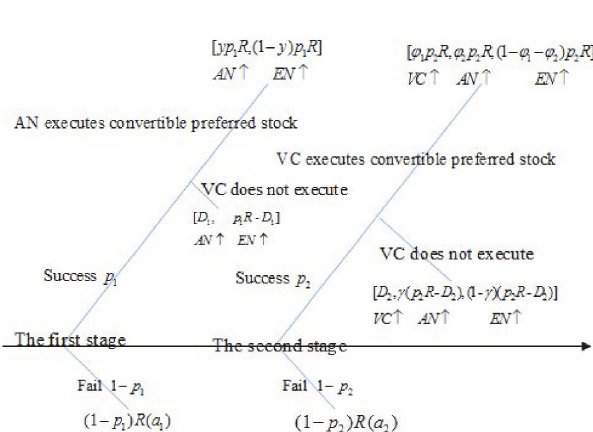
Figure 2: AN participates, the two-stage contract design.